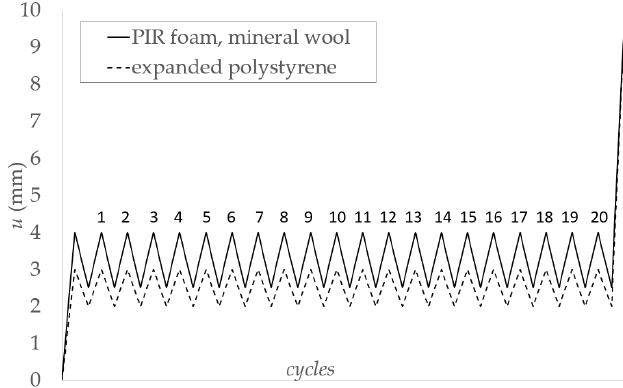
Figure 5. Displacement control program for quasi-cyclic loading.